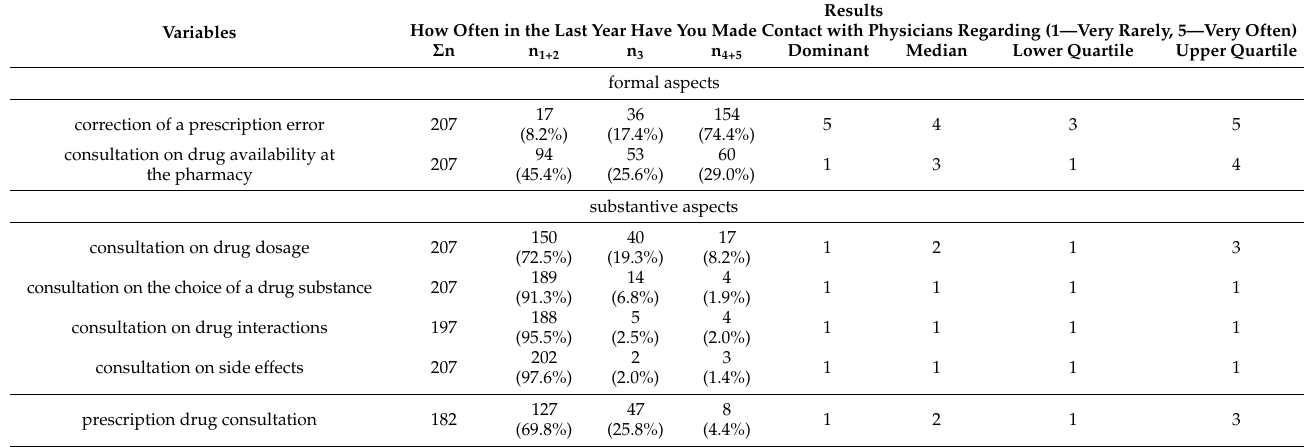
Table 3. The purpose of contact with physicians.